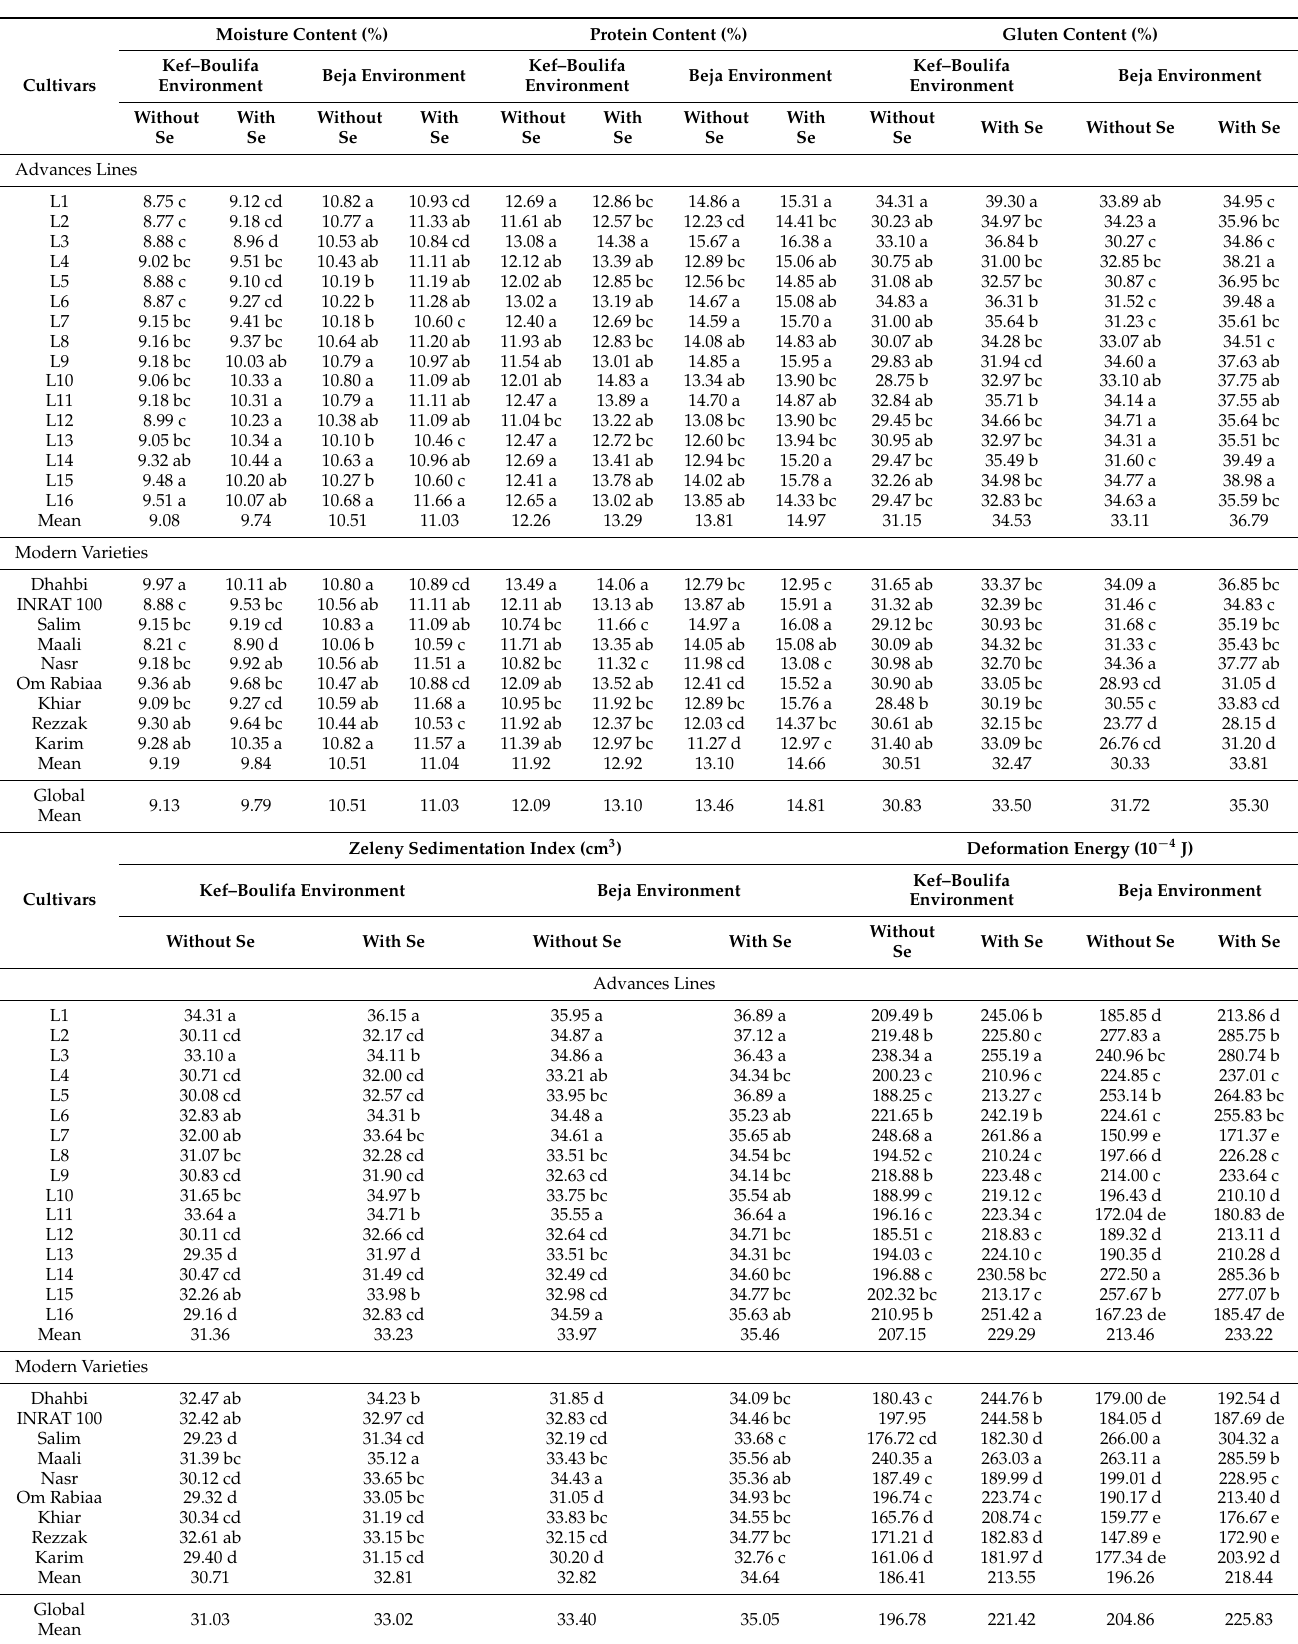
Table 4. Grain quality attributes of 25 durum wheat cultivars across the two